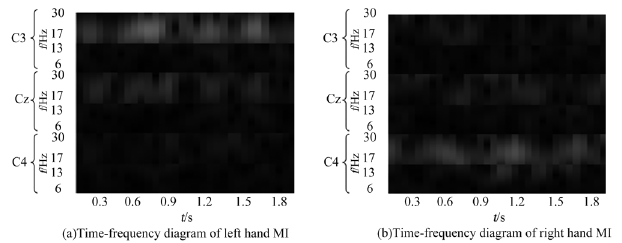
Figure 12. Time-frequency diagram of MI in subject 3